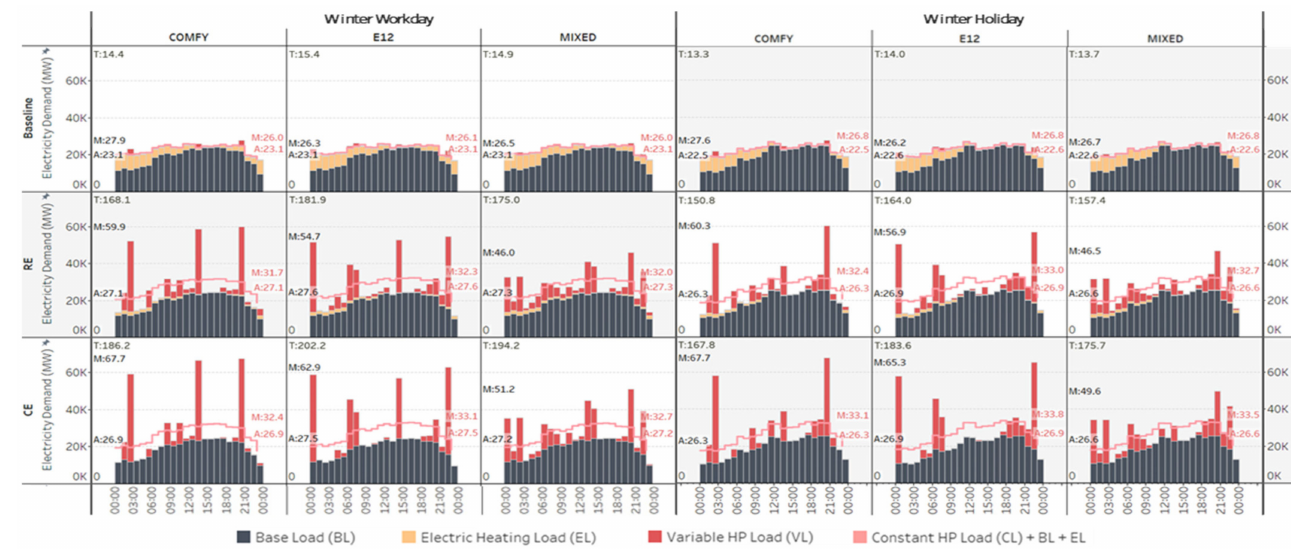
Figure 17. Average hourly electricity demand load curve of heat pump scenarios for Orkney for the coldest winter workday and holiday (T: Total, M: Maximum, A: